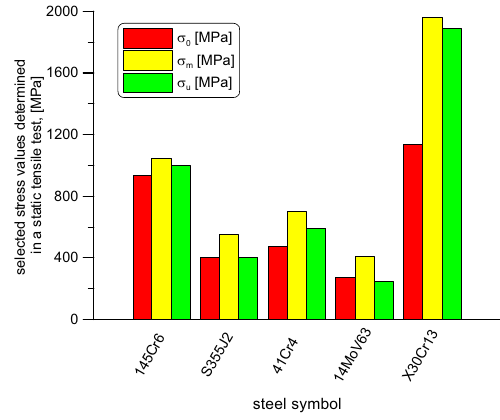
Figure 4: Comparison of the selected stress values determined in static tensile